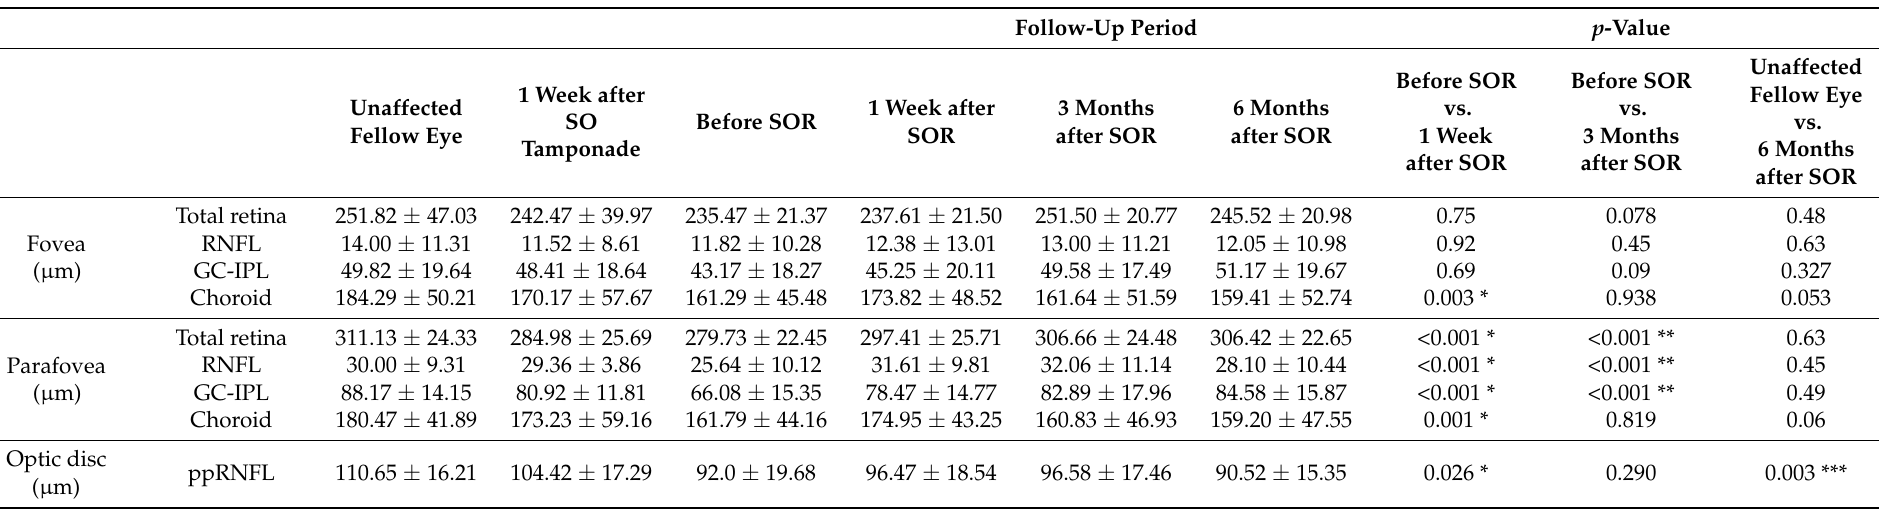
Table 2. Retinal and choroidal thickness changes in the fovea and parafovea ETDRS subfields before and after silicone oil